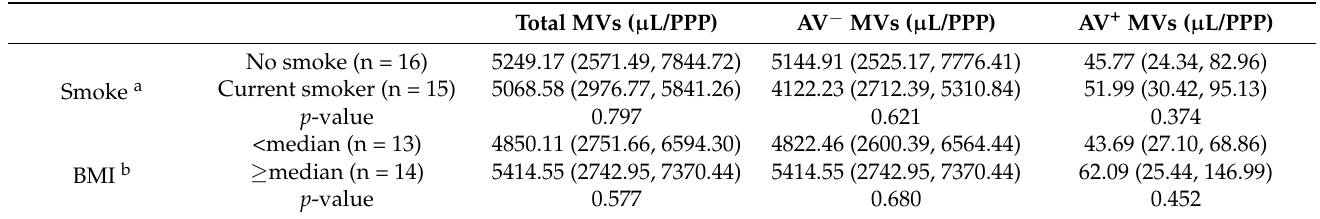
Table 6. Total, AV − , and AV + MVs as related to clinical characteristics in the STEMI population (median (25th and 75th